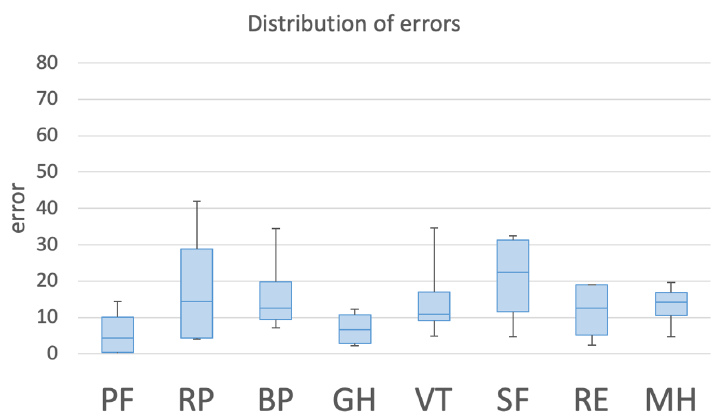
Figure 8. Distribution of errors between the estimated scores and the actual